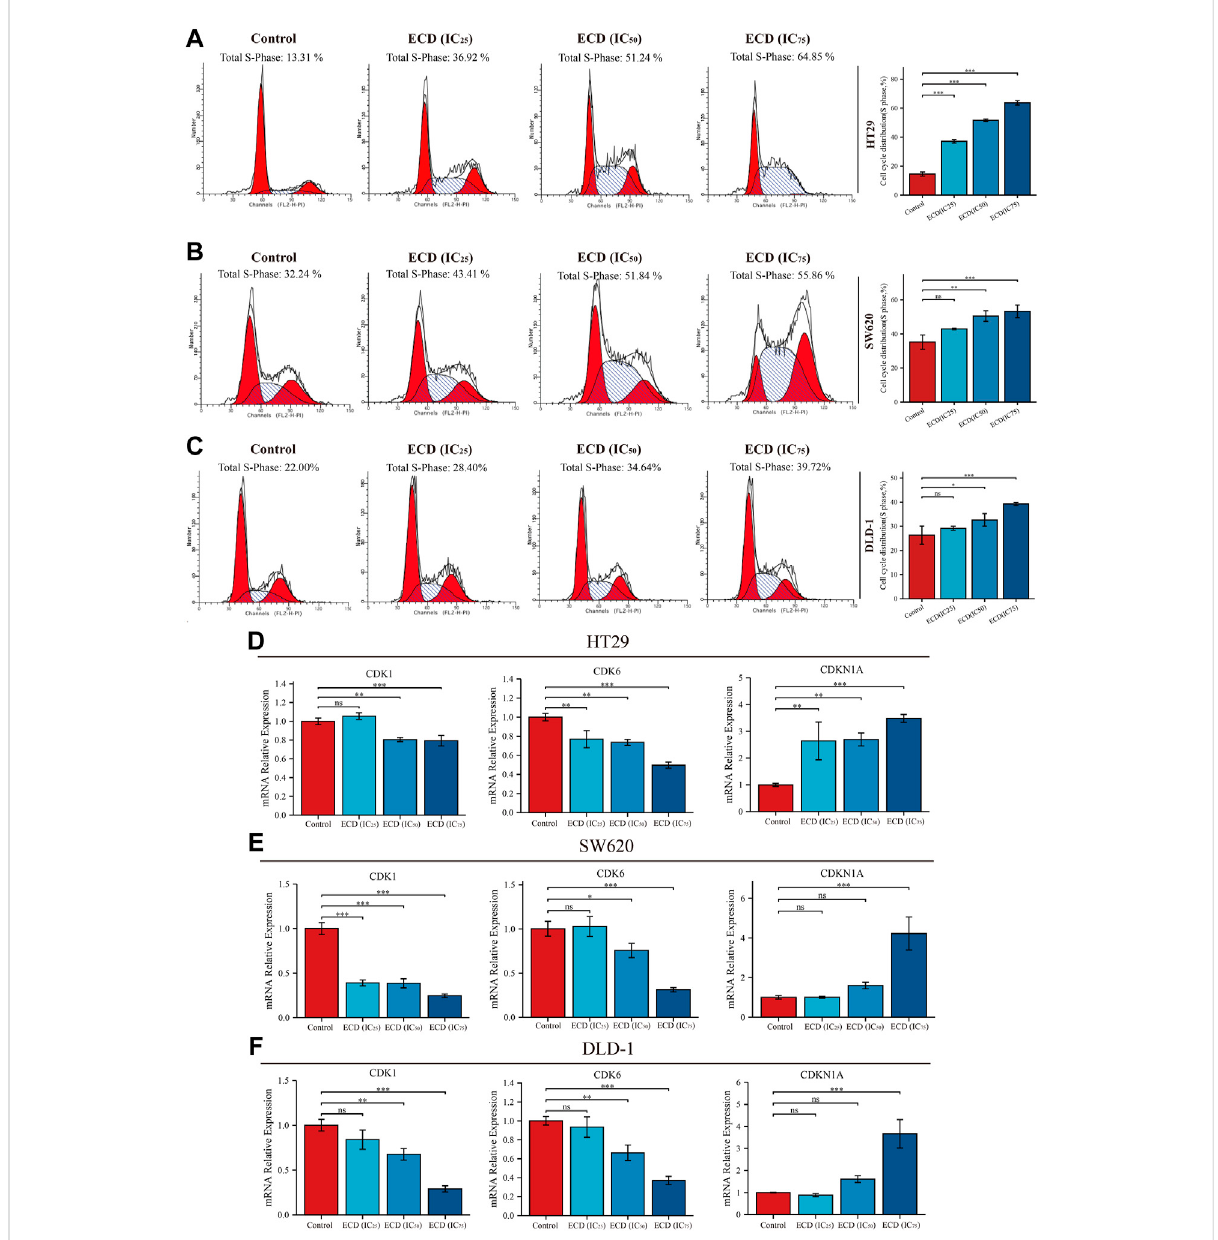
FIGURE 8 ECD inhibited cell cycle of CRC cells. A-C. Cell cycle analyses of HT29 (A) , SW620 (B) , and DLD-1 (C) cell lines treated with different working concentrations(IC 25 ,IC 50 ,andIC 75 )ofECDfor48 hmeasuredby fl owcytometryassay( n =3pergroup).D-F.ThemRNArelativeexpressionofCDK1, CDK6, and CDKN1A in HT29 (D) , SW620 (E) , and DLD-1 (F) cell lines treated with different working concentrations (IC 25 , IC 50 , and IC 75 ) of ECD